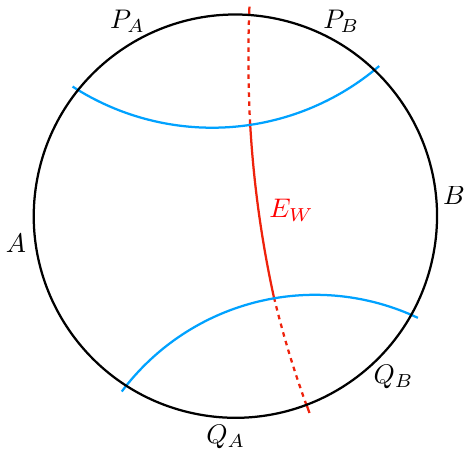
Figure 1 . The entanglement wedge cross section of the AB boundary subsystem, with size E W . This object, depicted as a red line, is the minimal surface that totally partitions the entanglement wedge into a region adjacent to A and one adjacent to B . It can be extended to a boundary- anchored geodesic (red dashed line), which further partitions the complement of A [ B into P A , P B , Q A , and Q B